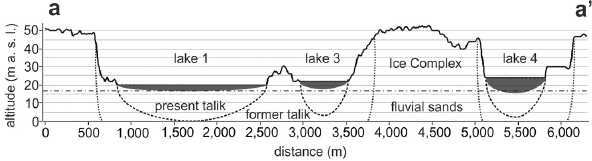
Fig. 11. Profile section across a Yedoma and thermokarst basin as- semblage on Kurungnakh Island (for position see Fig. 10) showing topographic positions of investigated features. The thaw potential of thermokarst is much greater on Yedoma uplands than in basins. The profile line was derived from the ALOS PRISM DEM, the depths of lakes from bathymetric measurements, and the approximate po- sition of the Ice Complex base from outcrop studies (Schirrmeister et al., 2003; Wetterich et al., 2008). Positions of taliks are hypo- thetical, based on modeling studies of similar environments in other regions (West and Plug, 2008).